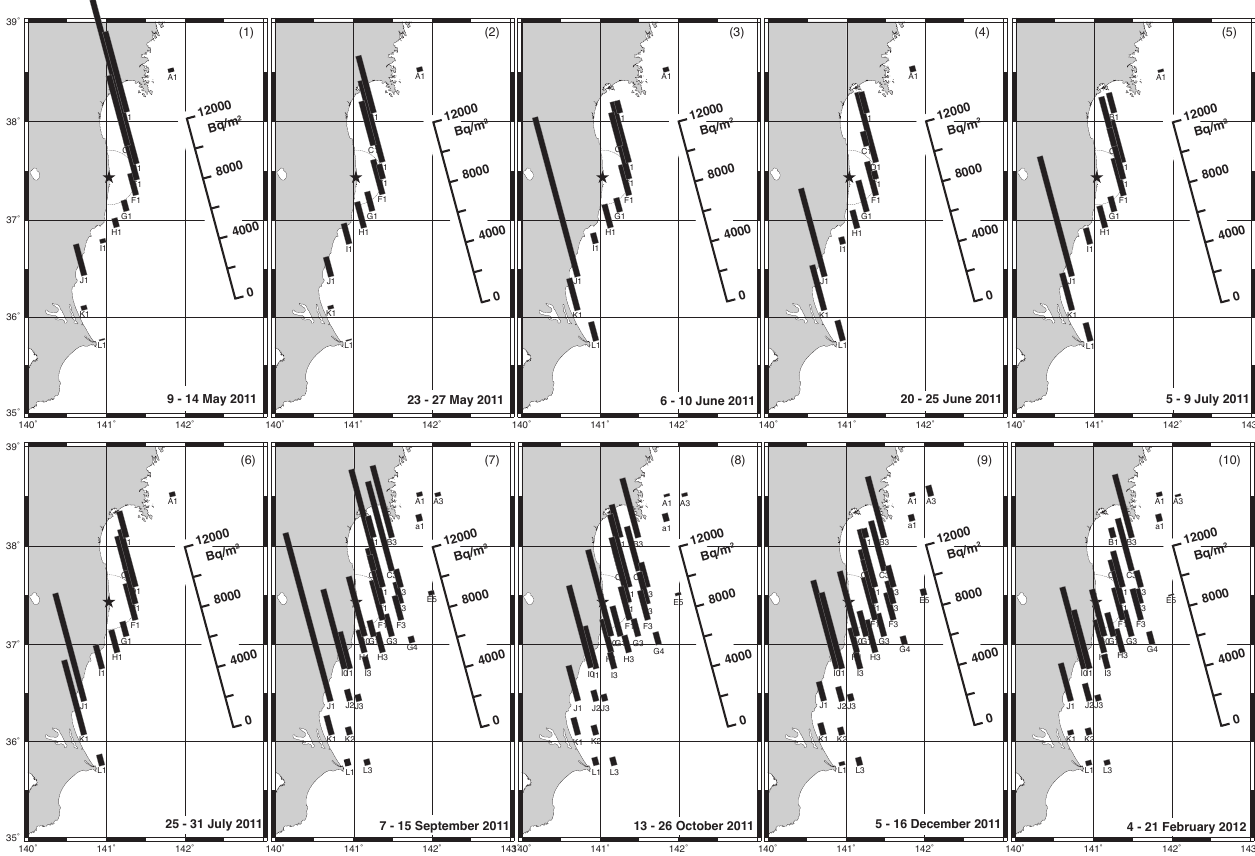
Fig. 7. Spatiotemporal variation of 137 Cs inventory in sediment samples collected on the dates indicated in the panels. Table 1. Inventories of 137 Cs in the upper 3cm of the surface sediments. Sampling Average Average Inventory c